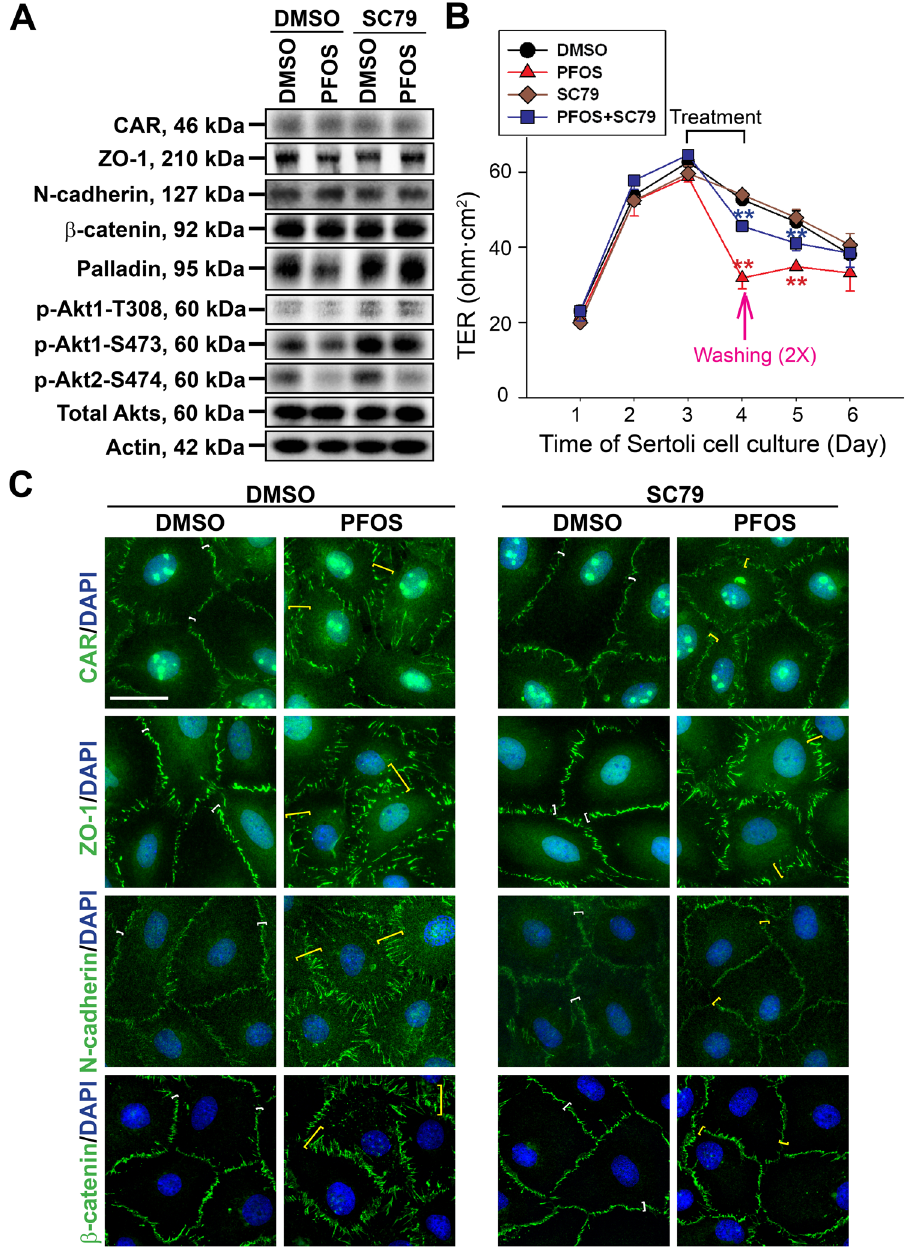
Figure 3. Akt activator SC79 blocks PFOS-mediated Sertoli cell TJ-barrier disruption and mis-localization of TJ and basal ES proteins at the BTB. ( A ) Sertoli cells cultured at 0.1 × 10 6 cells/cm 2 (in 6-well dishes with 2 ml F12/DMEM per well) for 3 days were pre-treated with SC79 at 2 μ g/ml (5.5 µ M) for 30 min. Cells were rinsed and treated with 50 μ M PFOS for 24 hr for immunoblotting. SC79 was found to up-regulate the PFOS-induced down-regulation of p-Akt1 T308 and p-Akt1 S473, but had no apparent effect in blocking the PFOS-induced down regulation of p-Akt2 S474. SC79 was also found to rescue PFOS-induced down-regulation on the expression of ZO-1, palladin. Actin served as a loading control. Composite analyzed data of immunoblottings are shown in Figure S2A; and uncropped blots are shown in Figure S5. ( B ) A study by TER to assess the ability of SC79 to block the PFOS-mediated disruption of the Sertoli cell TJ-permeability barrier function. Treatment of PFOS alone perturbed the TJ-barrier function, ** P < 0.01, by Student’s t -test compared between PFOS treated cells vs . control (DMSO) cells; ** P < 0.01, by Student’s t -test compared between PFOS + SC79-treated cells vs. PFOS-treated cells. ( C ) Sertoli cells cultured at 0.04 × 10 6 cells/cm 2 for 3 days were pre-treated with 2 μg/ml SC79 for 30 min, and then cells were rinsed and treated with 20 μM PFOS for 24 hr. Thereafter, cells were then fixed and examined by immunofluorescence microscopy. SC79 treatment was found to block PFOS-induced mis-localization of TJ proteins CAR and ZO-1, as well as basal ES proteins N-cadherin and β -catenin. BTB-associated proteins at the Sertoli cell-cell interface in control and PFOS-treated cells were annotated by corresponding white and yellow brackets, respectively. Composite analyzed data of this experiment are shown in Figure S2B. Sertoli cell nuclei were visualized by DAPI. Scale bar, 30 μ